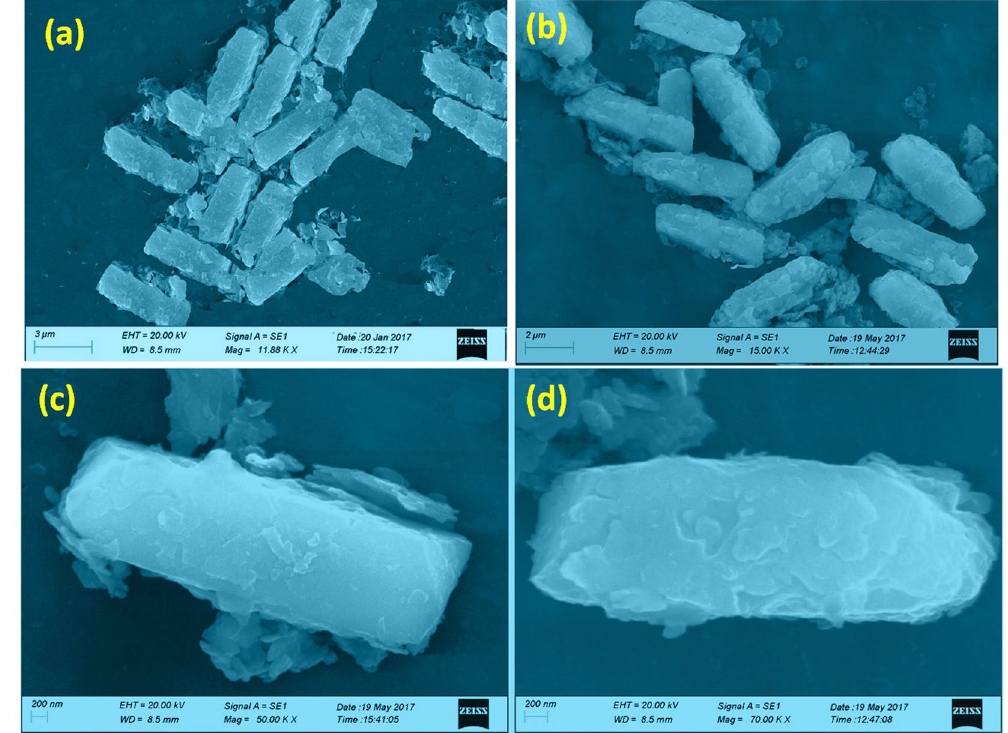
Figure 5. Low magnification FE-SEM images of ( a ) Cu 3 (PO 4 ) 2 -EG and ( b ) 8RGO-Cu 3 (PO 4 ) 2 -EG, high magnification SEM images of ( c ) Cu 3 (PO 4 ) 2 -EG and ( d ) 8RGO-Cu 3 (PO 4 ) 2 -EG showing “caramel-treat-like